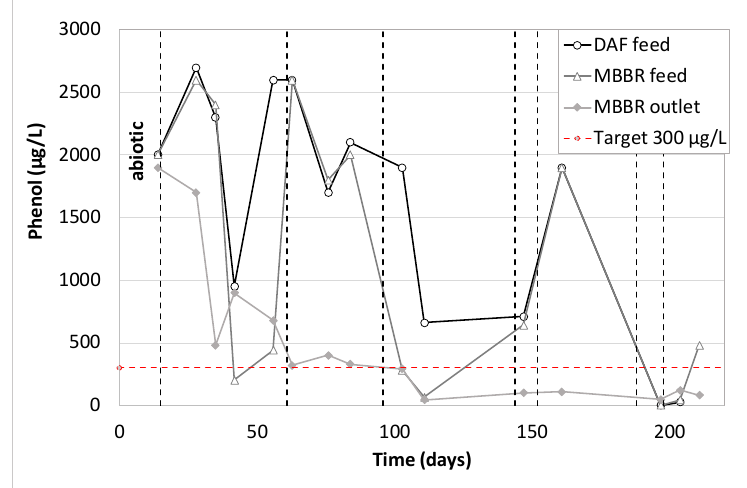
Figure 19. Aluminum concentration along the pilot unit versus time of operation.